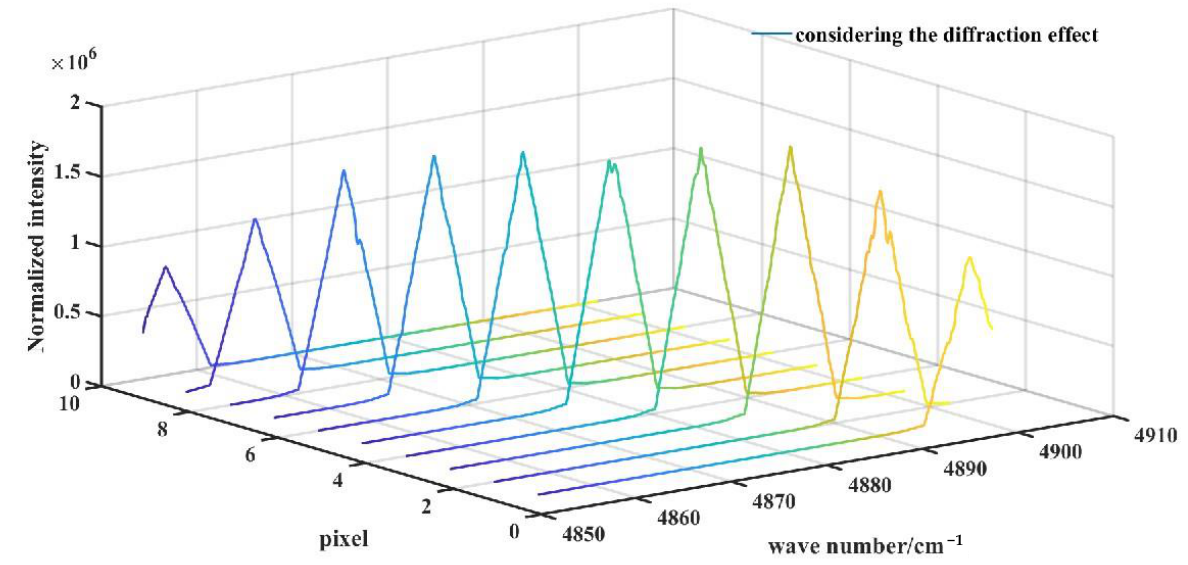
Figure 11. Recovered spectra of each pixel, considering the diffraction